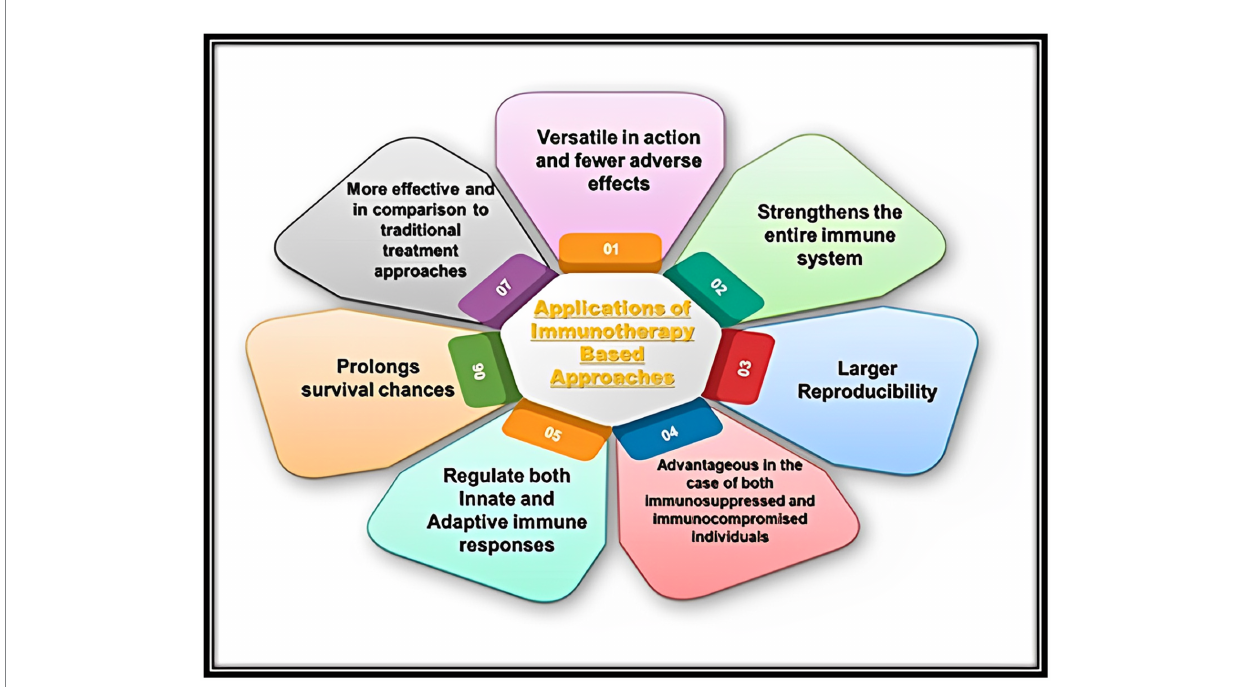
FIGURE 6 Representation of various applications of immunotherapy-based approaches in the case of treatment of different kinds of human infectious microbial (Bacterial and Fungal)